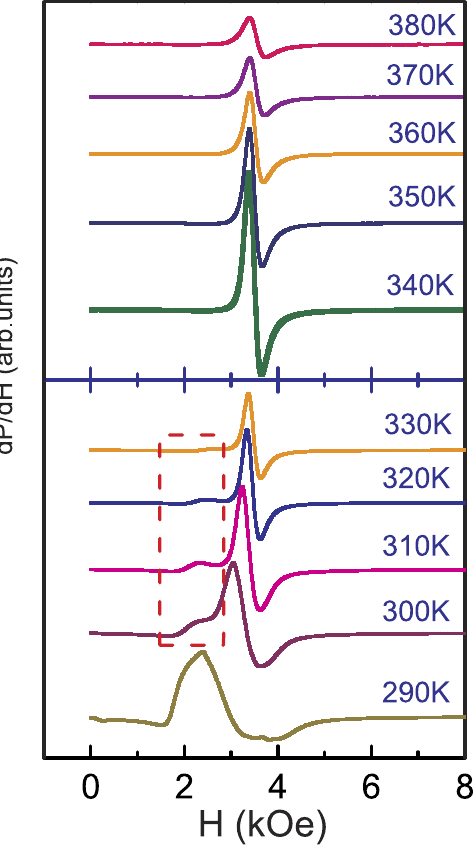
Figure 2. EPR spectrum of manganite La 0.6 Er 0.1 Sr 0.3 MnO 3 at temperatures of 290 K ≤ T ≤ 380